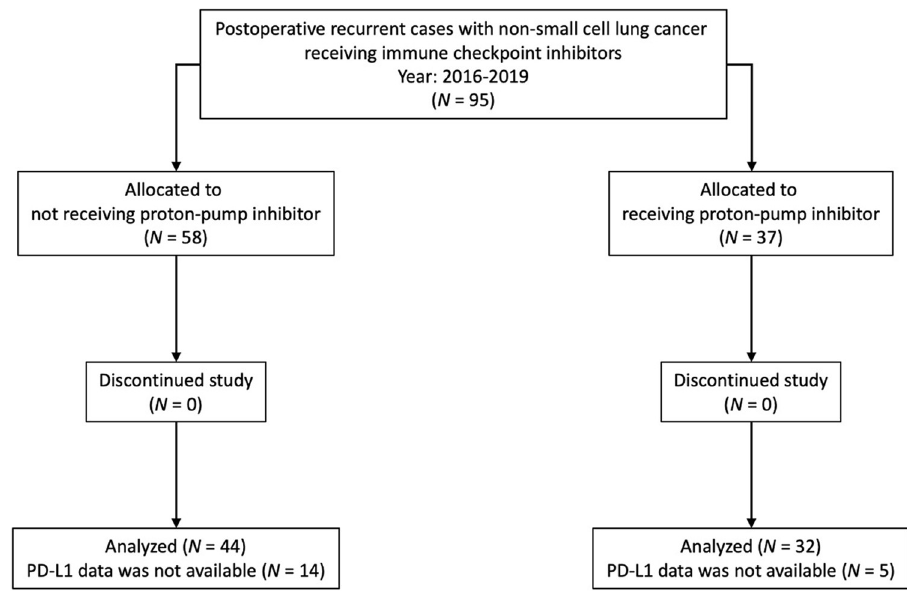
Fig 1. CONSORT diagram. CONSORT diagram in this study.